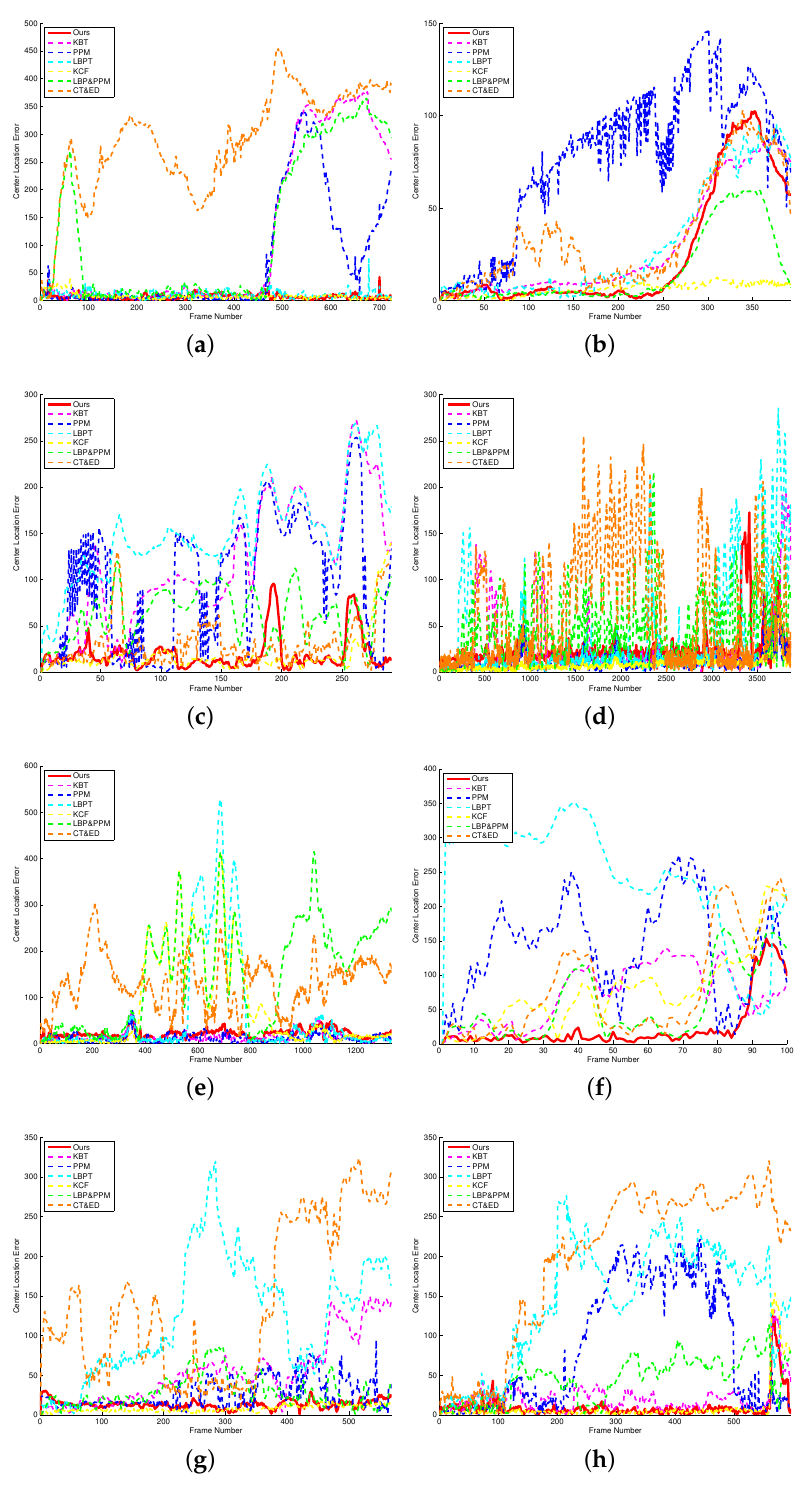
Figure 9. Fame-by-frame comparison of center location errors (in pixels) on eight challenging sequences. Based on the experimental results, our algorithm is able to track targets accurately and stably. ( a ) Basketball; ( b ) Car; ( c ) Coke; ( d ) Doll; ( e ) Lemming; ( f ) Matrix; ( g ) Trellis; ( h )